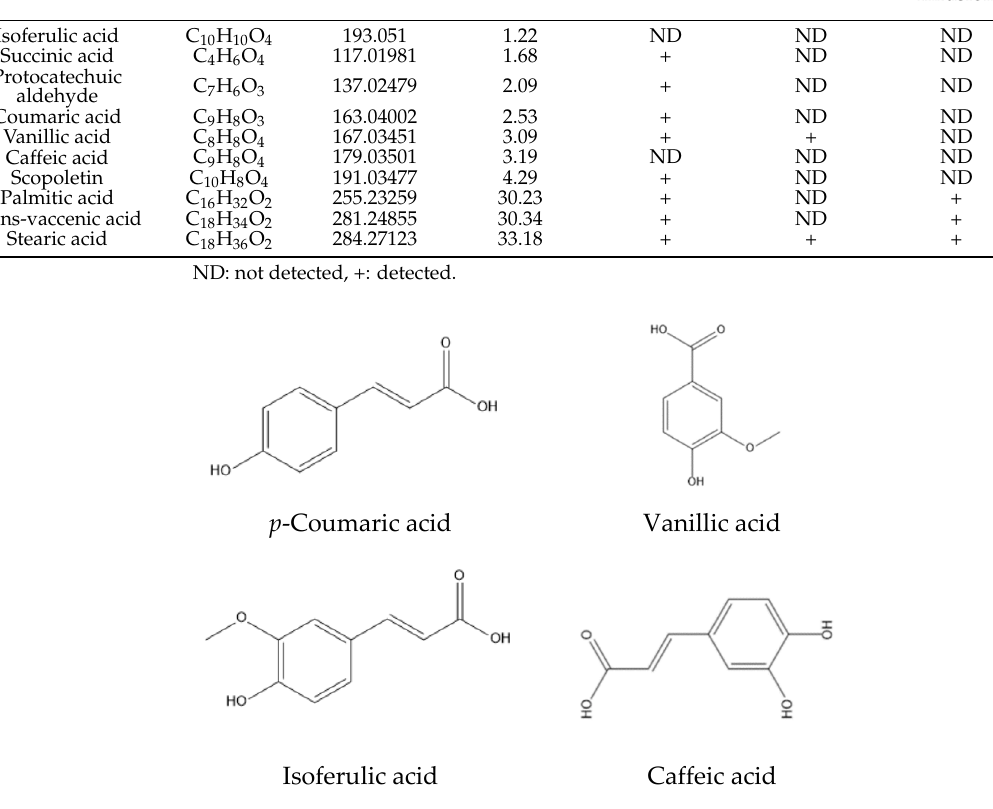
Figure 2. Chemical structures of the phenolic acids found in Terfezia claveryi .